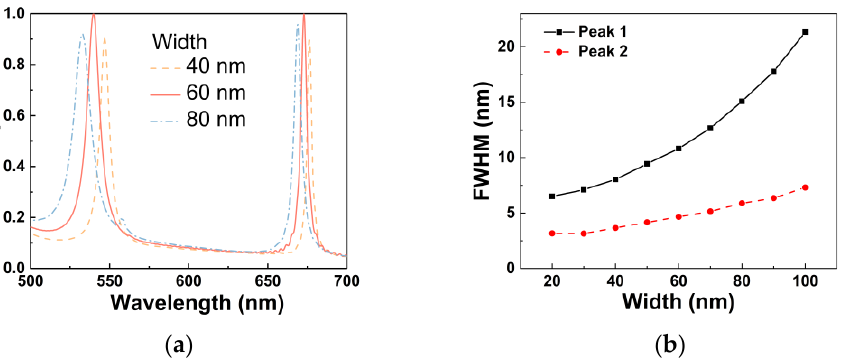
Figure 4. ( a ) Absorption spectrum for different width of nanocavity. ( b ) The relation between FWHM of absorption peak and width.